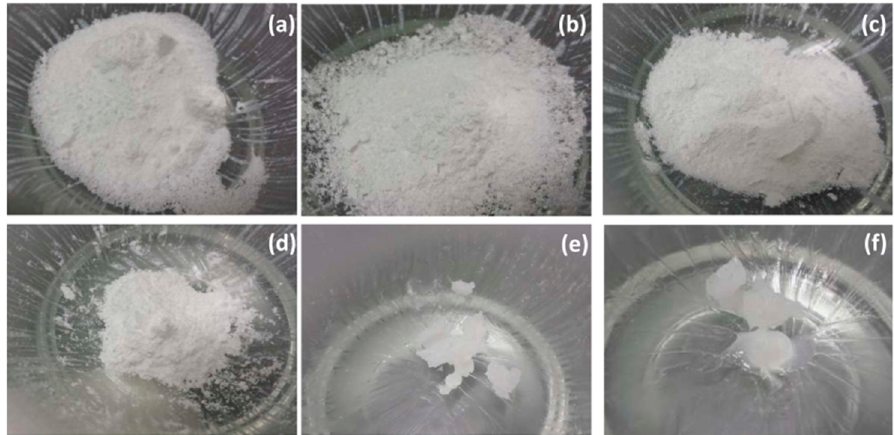
Figure 1. Visual effect of Neusilin ® US2 on physical state of Labrasol ® . Ratio of Neusilin ® US2 to Labrasol ® are ( a ) 1:0, ( b ) 0.75:0.25, ( c ) 0.67:0.33, ( d ) 0.5:0.5, ( e ) 0.33:0.67, ( f ) 0.25:0.75 (Maher unpublished). Table 2. Disintegration times and break strength values for a panel of formulations containing Labrasol ® , Neusilin ® US2 and a disintegrant (Croscarmellose Sodium). Disintegrant Tableting Pressure Break Strength Formulation Additives (% w/w) (psi) (N) Labrasol and Neusilin ® US2